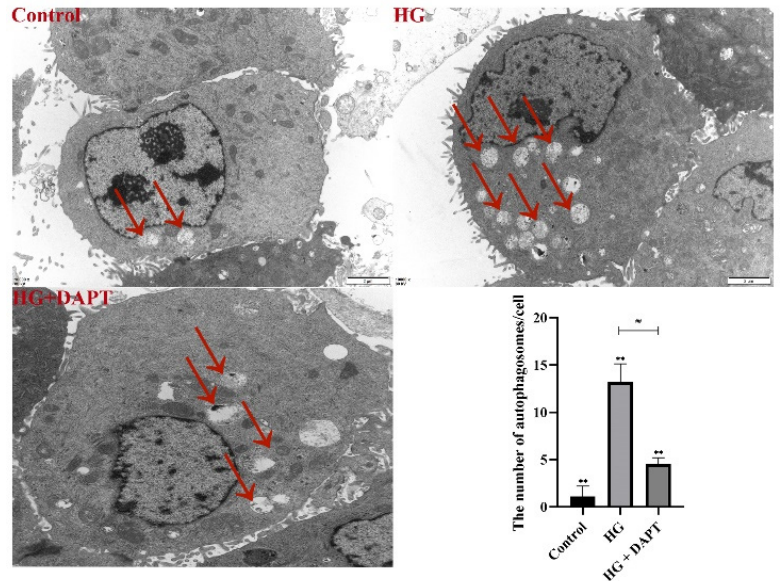
Figure 7. Autophagosomes under TEM. MDBK cells are pretreated for 6 h with 10 µM DAPT, and then stimulated for another 24 h with 25.5 mM glucose. TEM images of autophagic vacuoles (red double arrow) were shown in MDBK cells from Control, HG, and HG + DAPT treatment groups